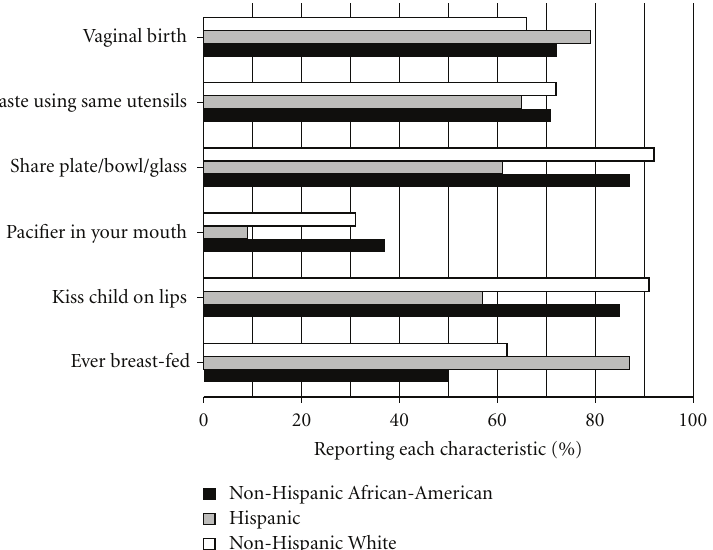
Figure 1: Relationships of race/ethnicity with oral bacteria transmission questionnaire responses (% responding “Yes”). Analyses were performed for each questionnaire item using multivariable logistic regression models with race/ethnicity, income, and education as predictors. Di ff erences among race/ethnicity groups were found for “ever breast fed” ( P = . 0004, highest for Hispanics), “kiss child on lips” ( P = . 0001, lowest for Hispanics), “share plate/bowl/glass” ( P = . 0001, lowest for Hispanics), and “pacifier in your mouth” ( P = . 0156, lowest for